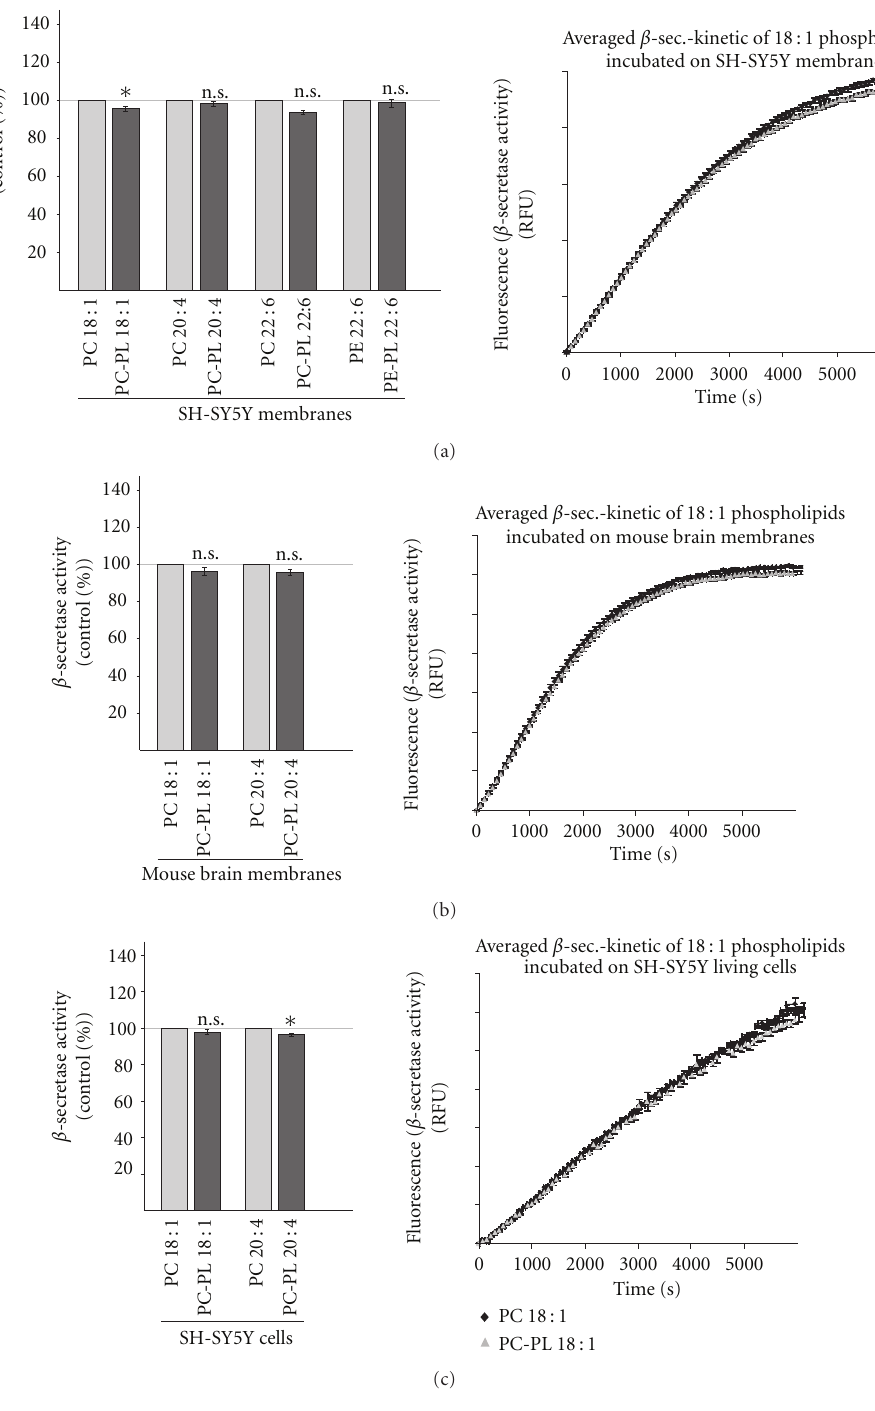
Figure 3: E ff ect of PC-PL 18:1, PC-PL 20 :4, PC-PL 22:6 and PE-PL 22:6 on β -secretase activity. (a) Influence on β -secretase activity in purified membranes of human SH-SY5Y cells. Purified membranes of SH-SY5Y cells were prepared, incubated with PC-PL 18:1, 20 :4, 22:6, or PE-PL 22:6 and the corresponding phospholipids (100 μ M), and β -secretase activity was determined by a fluorometric assay. A representative kinetic is shown for PC-PL 18: 1 and PC 18 :1. (b) Influence on β -secretase activity ex vivo in purified membranes of mouse brains. Purified membranes of mouse brains were incubated with PC-PL 18:1 and PC-PL 20:4 and the corresponding phospholipids PC 18:1 and PC 20:4 (100 μ M). A representative kinetic is shown for PC-PL 18 :1 and PC 18: 1. (c) Living SH-SY5Y cells were incubated in cell culture with PC-PL 18:1 and PC-PL 20:4 and the corresponding phospholipids in a final concentration of 100 μ M for 24 hours. After the incubation, purified membranes were prepared and analyzed in the β -secretase assay. A representative kinetic is shown for PC-PL 18: 1 and PC 18: 1. (a, b, c) All quantified data represent an average of at least three independent experiments. Illustration and statistical significance are as described for Figure